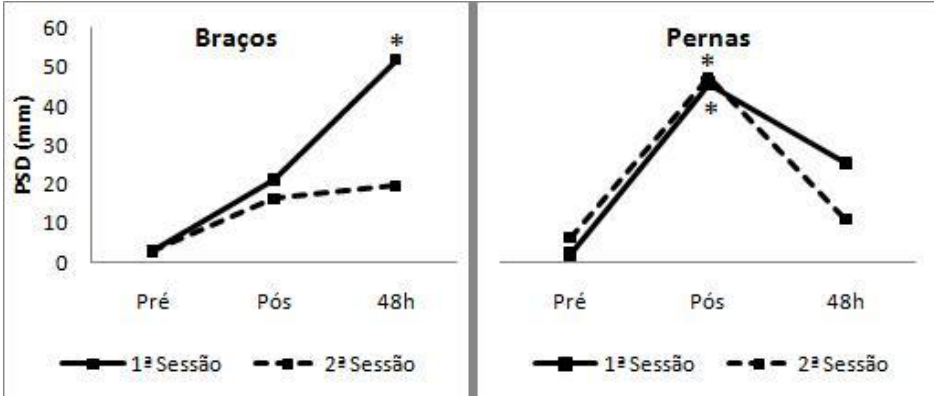
Figura 3. Mudanças na PSD antes, imediatamente depois e 48 horas após as 2 sessões de EEM para os grupos GB e GP. Os asteriscos (*) indicam diferença significativa (p<0,05) em relação à condição basal da respectiva sessão.